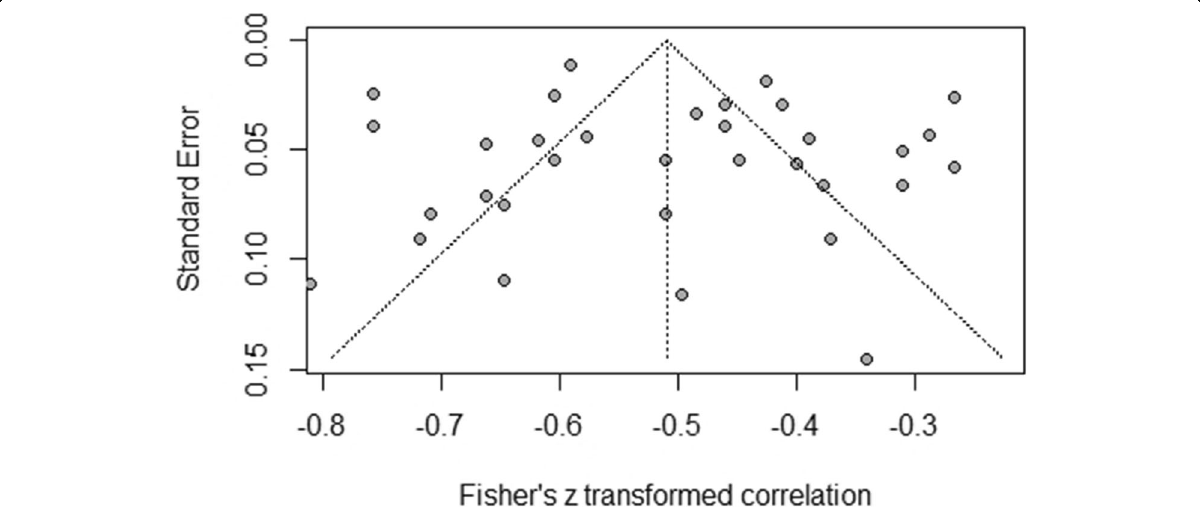
Fig. 4 Begg ’ s funnel plot for publication bias of general meta-analysis. Begg ’ s funnel plot for publication bias on the relationship between dispositional optimism and depression in young people. The standard error of the transformed effect size is shown on the y-axis, and the pooled Fischer Z -values are presented on the x